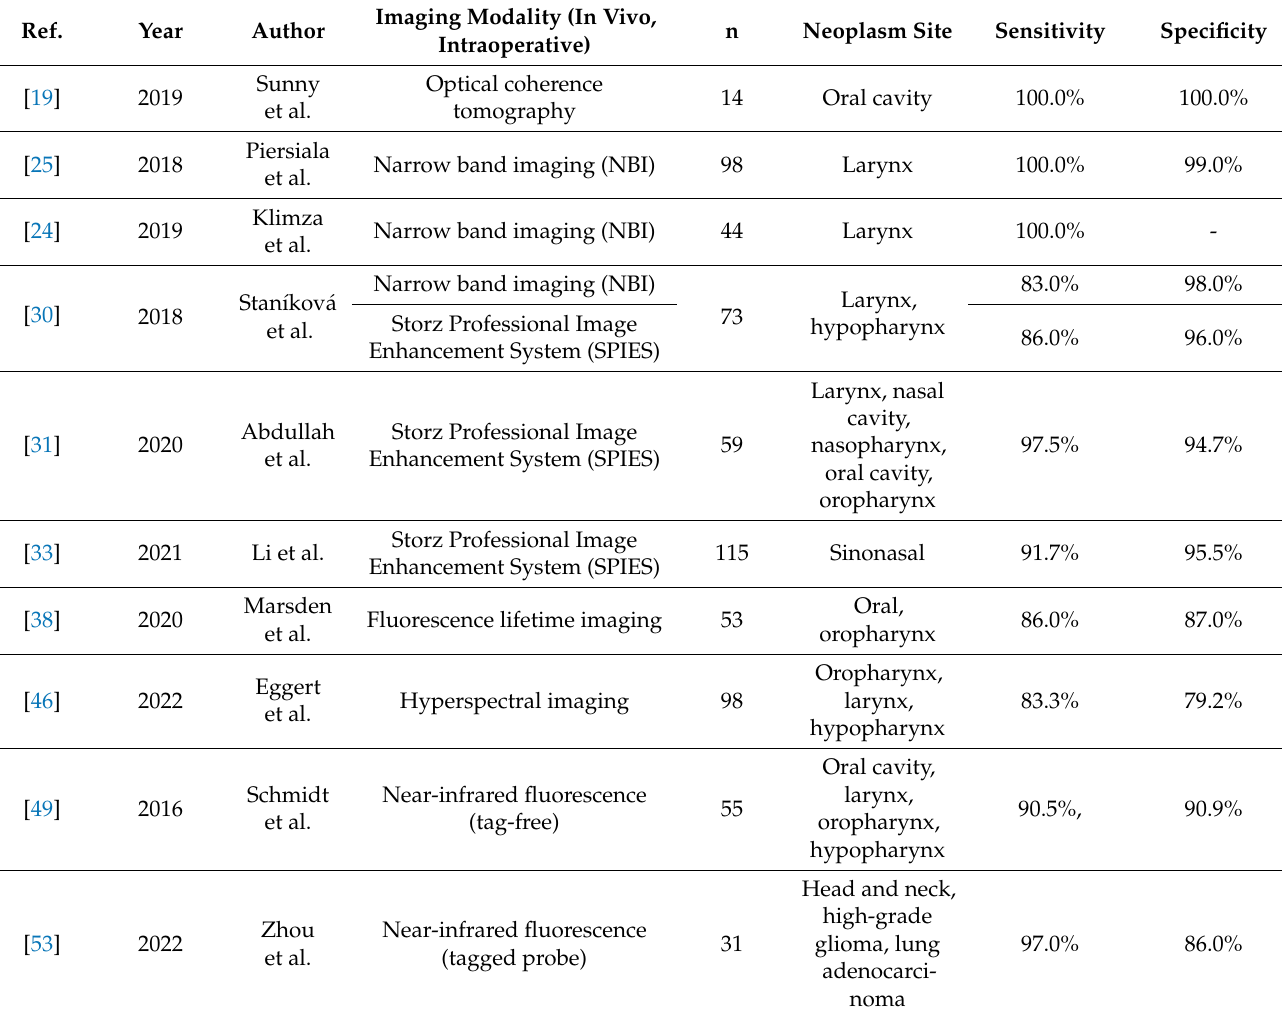
Table 2. Studies reporting sensitivity and specificity in delineating cancerous from healthy tissues.